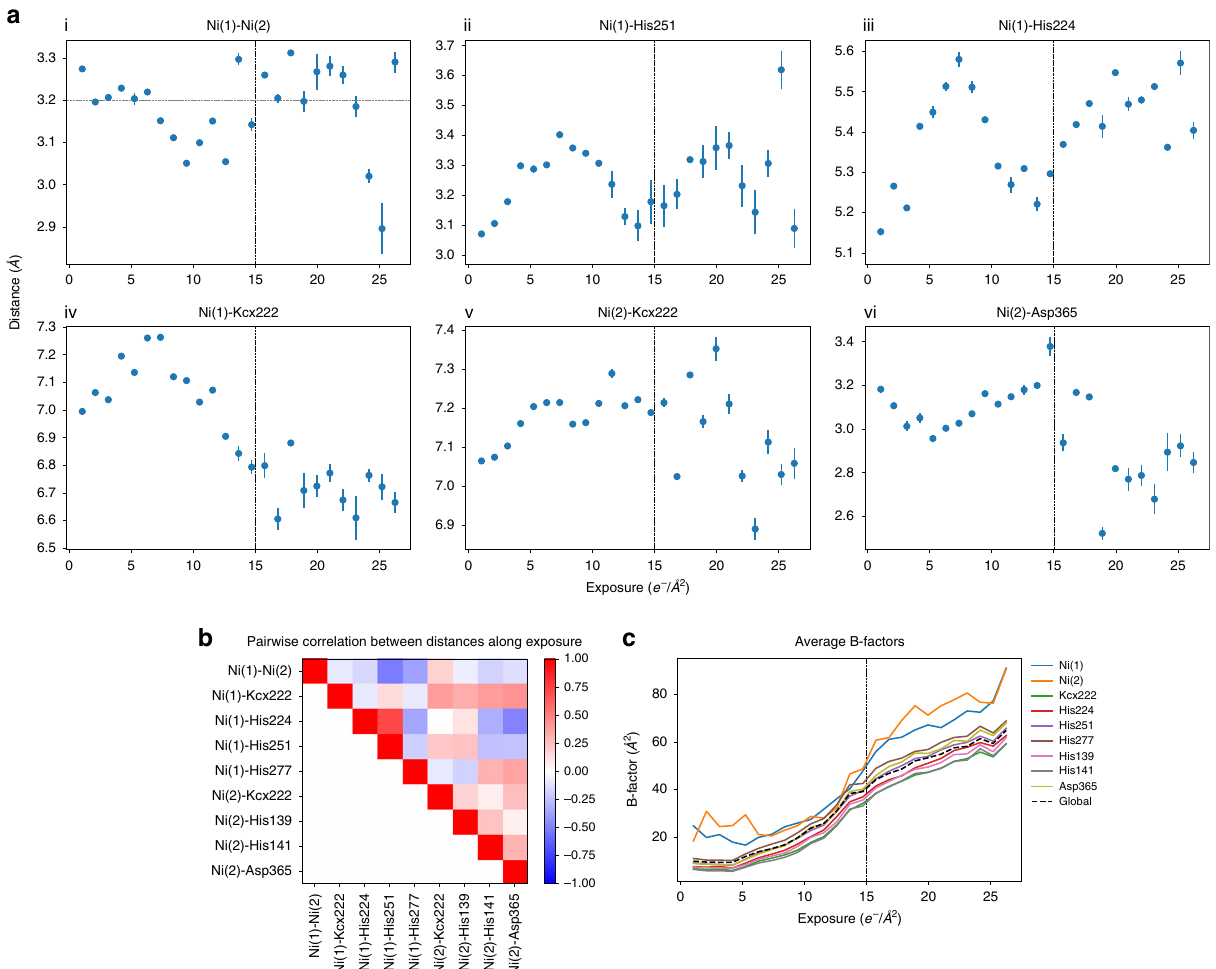
Fig. 6 Radiation damage affects the distance between residues in the active site. a Distances between the Ni 2 + ions and selected residues involved in their coordination are plotted against the accumulated exposure. For each reconstruction calculated along the exposure, the model was re fi ned, and distances measured. Dots indicate the average and error bars show ±one standard deviation across fi ve re fi nement runs with different random seeds. Horizontal dashed line in a – i shows the distance in the model obtained from the full reconstruction with all frames. Vertical dashed lines show approximately the exposure at which the density for charged residues completely vanishes (see Supplementary Movie 2). b Correlation coef fi cients between distance changes along the exposure for selected residues involved in ion coordination. Distance plots shown in a are indicated with a star. c Average B-factors of selected residues and of the global structure (from fi ve re fi nement runs) plotted against the accumulated and Ni(2) tend to come closer to the carbamylated Lys222 (Fig. 6a-iv, v) as Asp365 vanishes (Fig. 6a-vi), which can be seen in the Supplementary Movie 2. Aspartic acid is known to have its side chain damaged very early on 32 . The dynamic interplay different rates at which speci fi c types of bonds and residues are